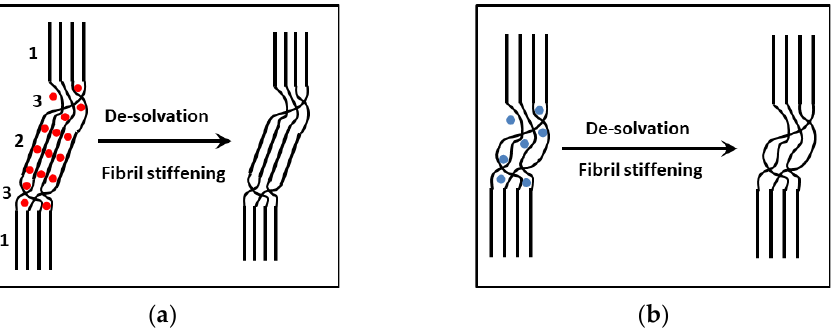
Figure 5. ( a ) Left: sketch of a PVC fibril showing organized sections made up of the highest syndio- tactic sequences (1), a solvated section corresponding to the formation of a PVC/solvent molecular compound [23] (2) and the solvated amorphous parts (3); right: after total de-solvation. ( b ) Left: sketch of PVC fibrils where no molecular compounds are formed; only organized sections and the plasticized domains are present. De-solvation occurs in the swollen amorphous domains (right).